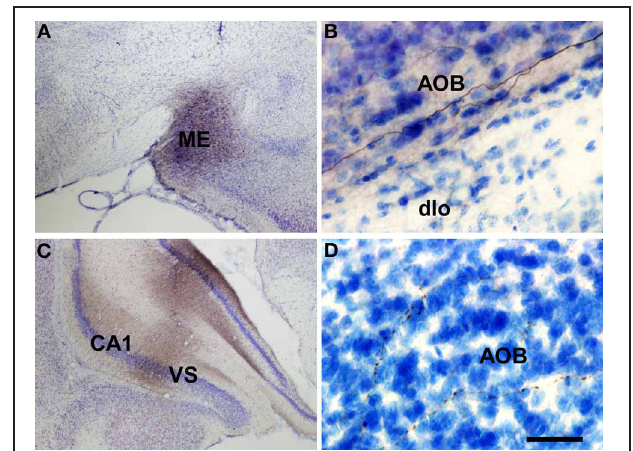
FIGURE 7 | Coronal (A,C) and sagittal (B,D) sections of the telencephalic hemisphere showing the resulting labeling (B,D) after biotinylated dextran-amine injections in the rat anterodorsal medial amygdaloid nucleus (A) and ventral subiculium (C), respectively. Abbreviations: AOB, accessory olfactory bulb; CA1, field CA1 of the hippocampus; dlo, dorsal lateral olfactory tract; ME, medial amygdala; VS, ventral subiculum. Scale bar for A : 800 μ m, B,C : 40 μ